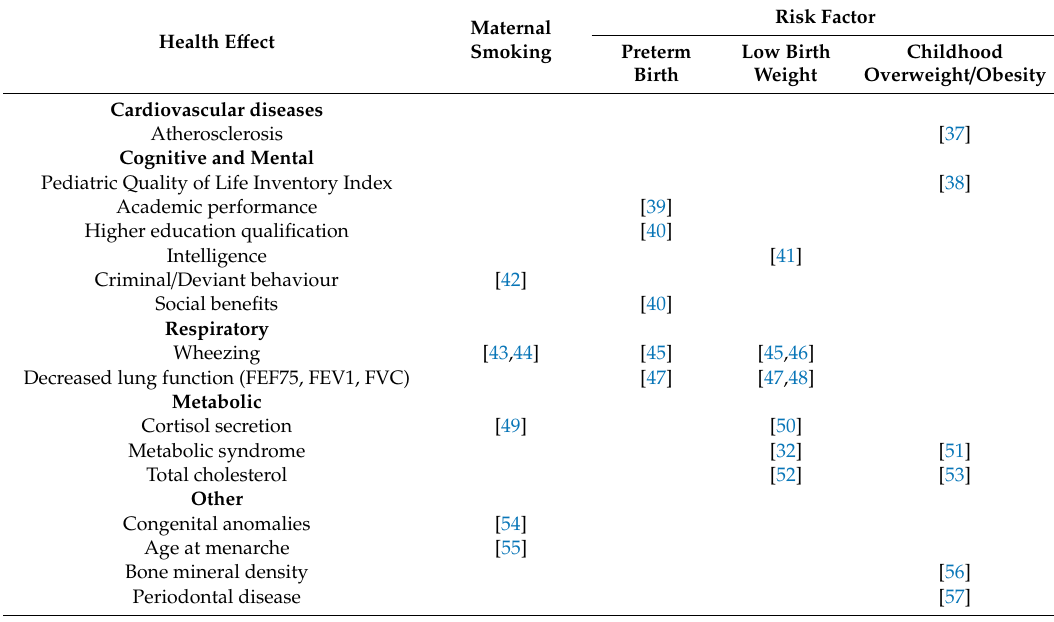
Table 3. Exemplary outcomes associated with maternal smoking and associated intermediate risk factors for which no background burden was available and therefore not quantified in this work